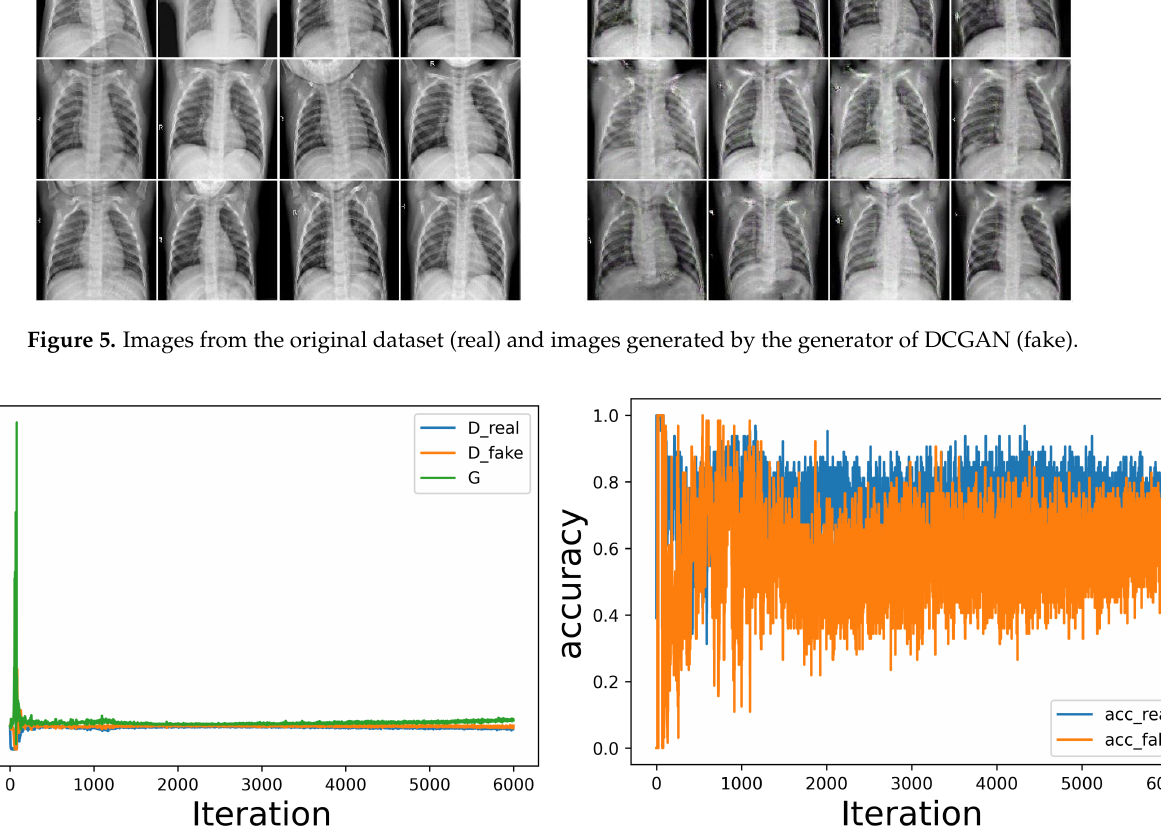
( a ) Loss. Figure 6. Generator and discriminator network loss and accuracy during